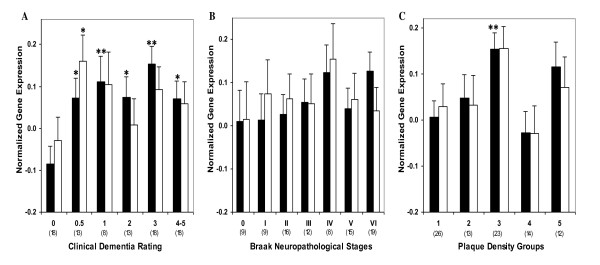
Normalized RXRα (Black bars) and LXRβ mRNA (white bars) expression in area 20 plotted against CDR scores, Braak neuropathological stages and NP density. ANCOVA was used to compare gene expression in individuals with varying degree of dementia (CDR 0.5-5) and AD associated neuropathology (Braak stage I-VI, NP density 2-5) relative to the control group. Mean values ± SEM are shown. *, p < 0.05; **, p < 0.01. Number within the parentheses indicates the individuals within each disease severity group.